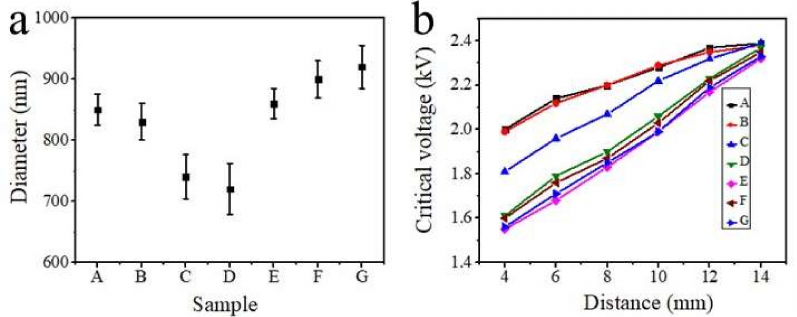
Figure 3. ( a ) Corresponding diameter analysis of Figure 2 and ( b ) the critical voltage of PVP nanofibers fabricated by NFES and PVP / γ -Fe 2 O 3 nanofibers by MES. The detailed synthetic information of Sample A-G is displayed in Table